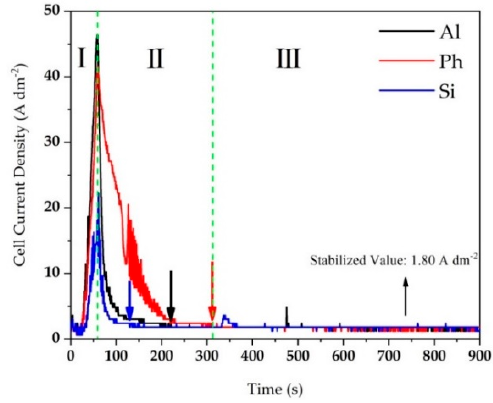
Figure 1. Cell current density vs. time response during plasma electrolytic oxidation PEO processing in various base-solutions.